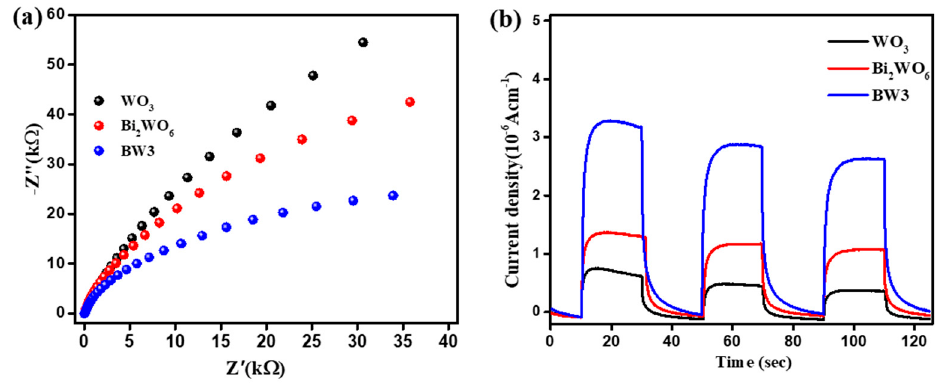
Figure 11. Electrochemical impedance spectra (EIS) ( a ) and photocurrents responses ( b ) of WO 3 , Bi 2 WO 6 and BW3 composite.